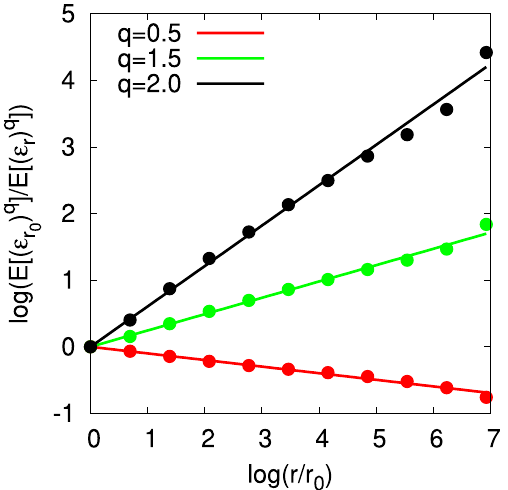
) q � , where r 0 log ( r / r 0 ) , − log � (ε r /ε r 0 (cid:30) (cid:31)